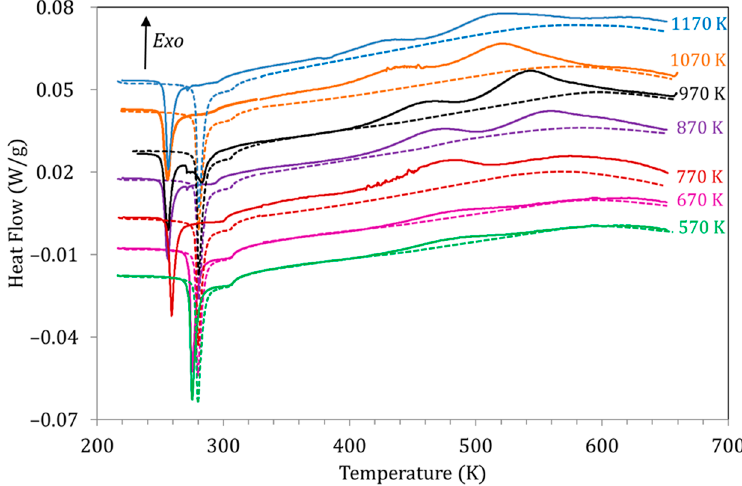
Figure 6. DSC curves obtained for alloy Cu5 during the first (solid lines) and second (dashed lines) heating runs after quench from different T WQ .